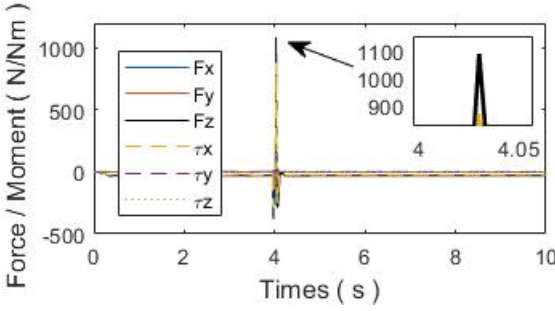
Figure 6. The contact force between shaft and hole in experiment 1.